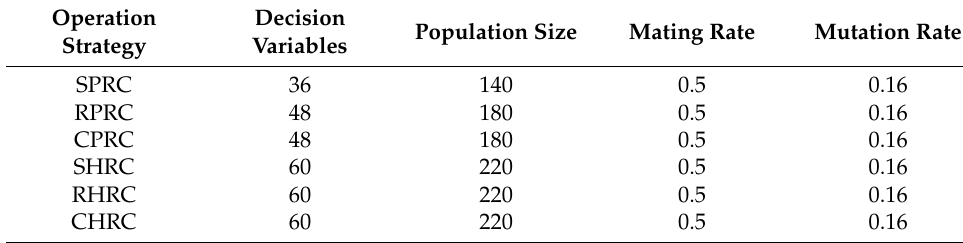
Table 1. Applied parameters value for optimization